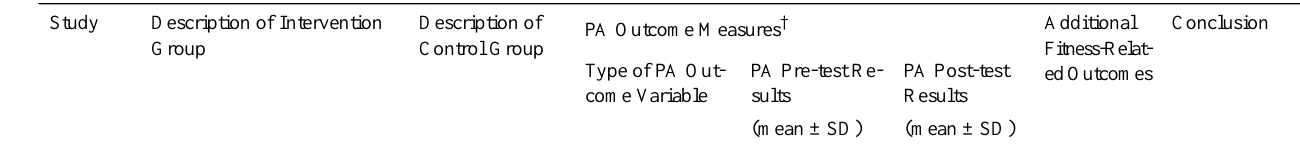
Table 4. Characteristics and results of the Internet-based physical activity interventions*